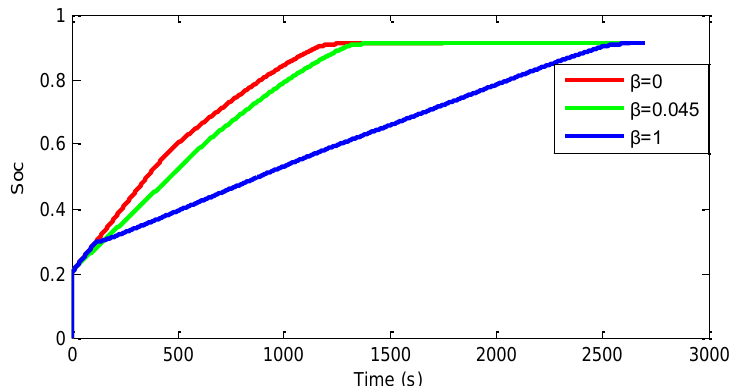
Figure 4. The dynamic property of SOC with different